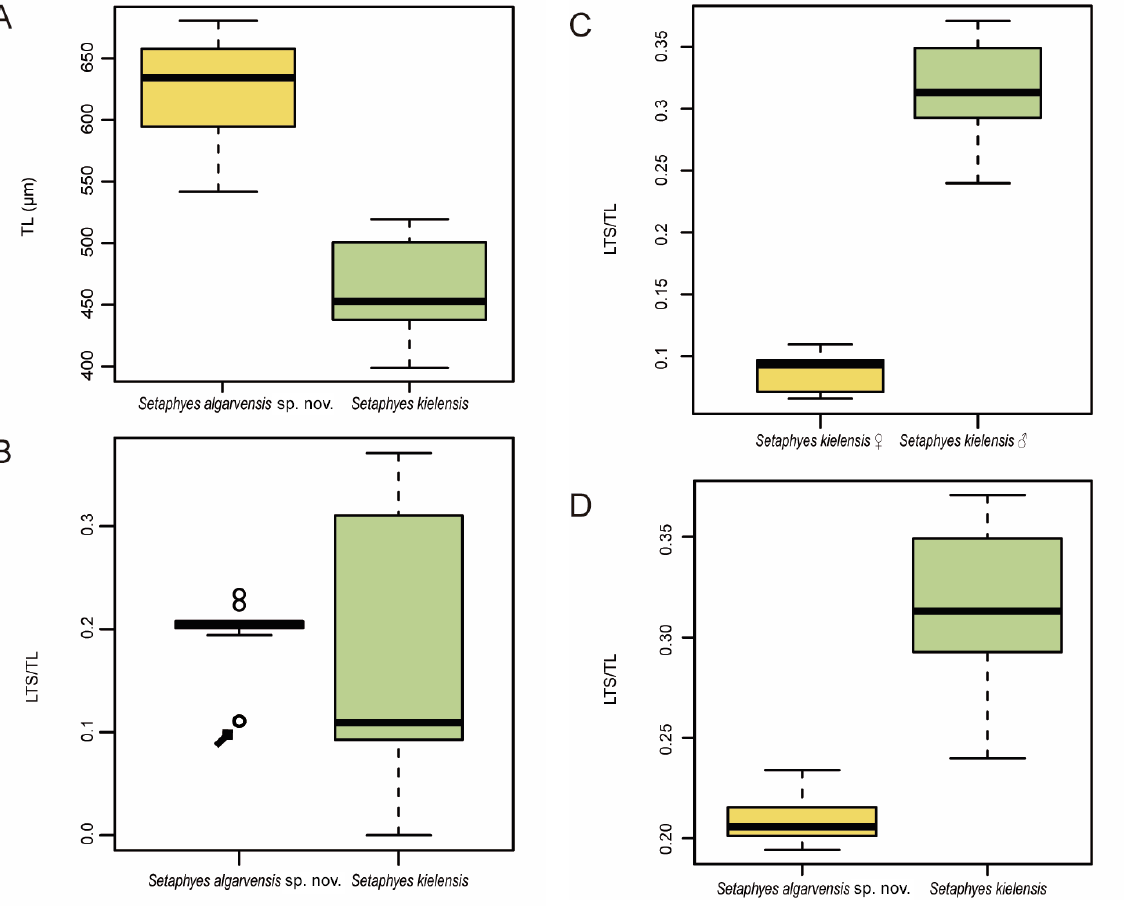
Fig. 5. Boxplots represent the ranges of different body measurements of Setaphyes algarvensis sp. nov., and S. kielensis (Zelinka, 1928). A . Total trunk length. B . Relationship between total trunk length and lateral terminal spine length; arrow points out the female of S. algarvensis sp. nov. C . Relationship between total trunk length and lateral terminal spine length among males and females of S. kielensis . D . Relationship between total trunk length and lateral terminal spine length among the males of both